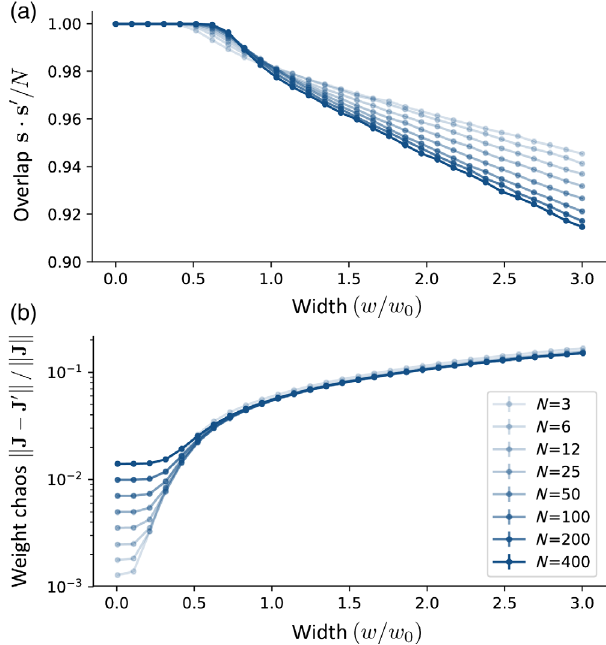
FIG. 14. The effect of weight chaos in experimental parameter regimes, using an ensemble placement uncertainty of 1 μ m and ffiffiffiffiffi p 1 = M fluctuations in atom number. The drift of metastable states between different realizations of noise weights is plotted in (a) as a function of the width w of the ensemble distribution and for different system sizes N [see the legend in (b)]. The states s and s 0 refer to metastable states of two realizations J and J 0 , respectively, as described in the text. (b) The direct change in the J connectivity matrix is plotted as a function of the